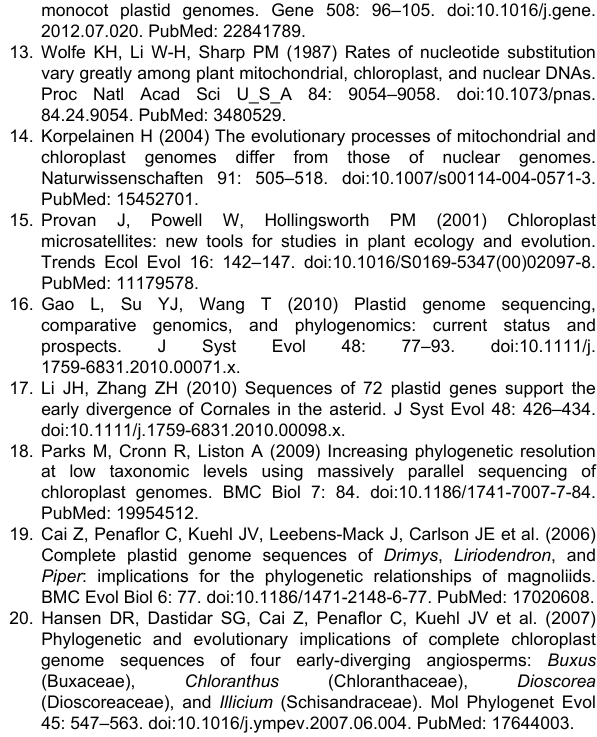
Table S1. Primers used for gap closure and junction verification.